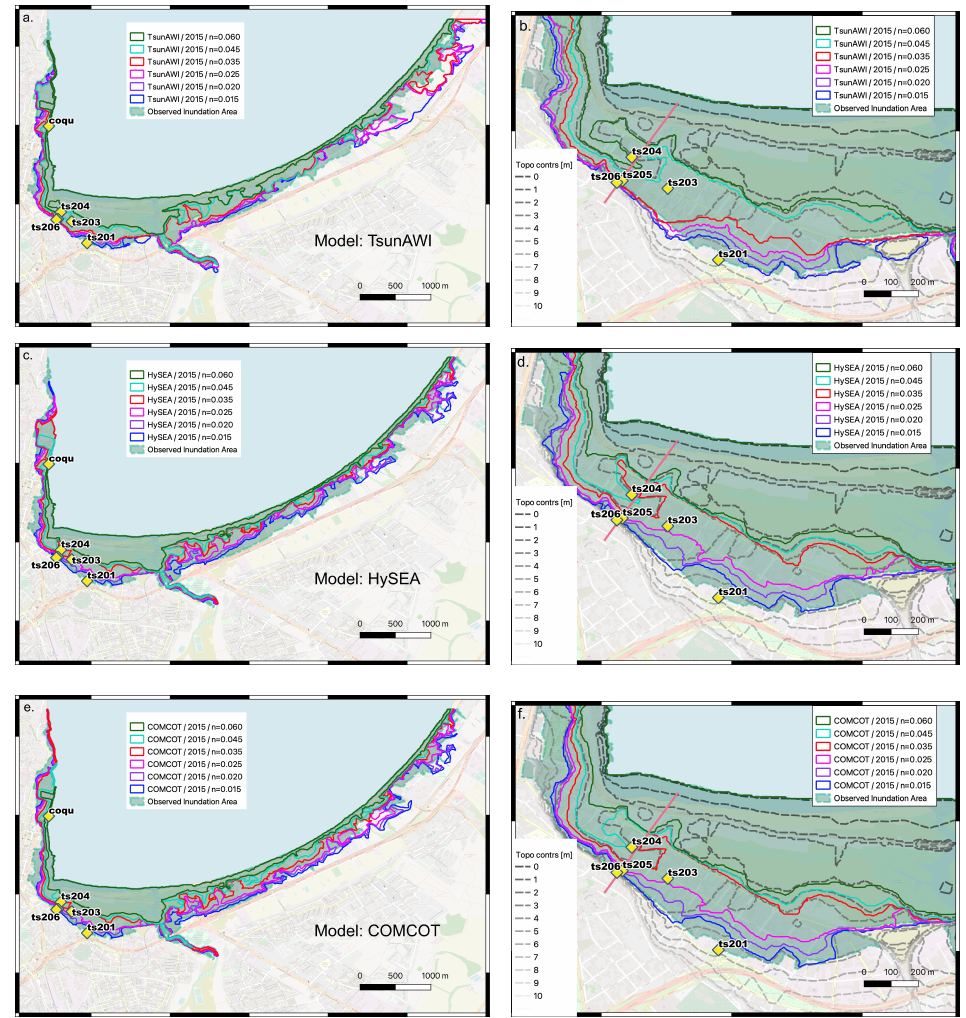
Figure 8. Comparison within each numerical model, testing different Manning n values. Boundaries showing the extent of inundation areas obtained by the numerical models for all Manning values for Experiment 2015 are shown in each panel: ( a ). All n values tested with the TsunAWI model for Coquimbo bay. ( b ). All n values tested with the TsunAWI model for southern Coquimbo bay (zoomed area). ( c ). All n values tested with the Tsunami-HySEA model along Coquimbo bay. ( d ). All n values tested with the Tsunami-HySEA model for southern Coquimbo bay (zoomed area). ( e ). All n values tested with the COMCOT model for Coquimbo bay. ( f ). All n values tested with the COMCOT model for southern Coquimbo bay (zoomed area). Yellow diamonds stand for virtual inland and tide gauges. Observed inundation area taken from SERNAGEOMIN [43]. Basemap: © OpenStreetMap